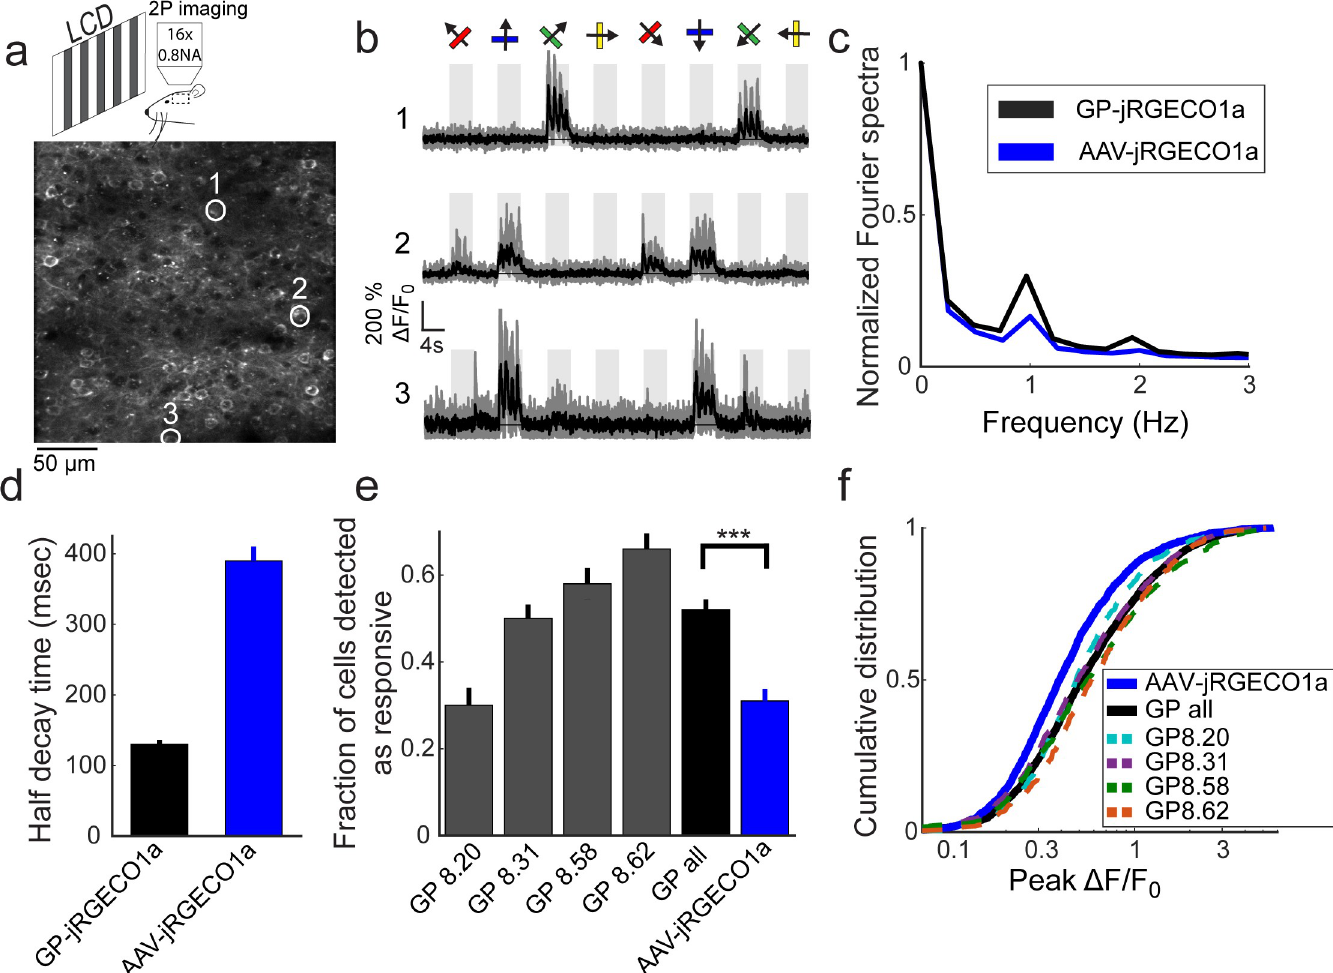
Fig 3. Functional imaging in the primary visual cortex of transgenic mice. a . Schematic of the experimental setup (top), and an image of GP8.31 layer 2/3 cells in the primary visual cortex (bottom, 120 μ m under the dura). b. Responses of three neurons in GP8.31 mice, indicated by circles in a, to drifting grating stimuli. The grating motion directions are indicated by arrows and shown above traces. Single trials (gray) and average of 5 trials (black) are overlaid. The preferred stimulus is the direction evoking the largest response. c. Fourier transform of the response to the preferred stimulus (median across all recorded cells) of GP-jRGECO1a and AAV-jRGECO1a. The 1 Hz peak corresponds to the frequency of the drifting grating (AAV-jRGECO1a, 472 significantly responsive neurons from 4 mice; GP-jRGECO1a, 1650 significantly responsive neurons from 8 mice) d. Half-decay time (mean ± s.e.) after the last response peak during stimulus presentation (GP-jRGECO1a, n = 522 cells from 8 mice; AAV-jRGECO1a, 395 cells from 4 mice). e , Fraction of significant responsive cells (ANOVA test, p < 0.01). Gray bars, single GP lines (n = 2 mice per line. GP8.20, 709 neurons in 14 FOVs; GP8.31, 1416, 19; GP8.58, 607, 12; GP8.62, 628, 19); black bar, averaged data from all GP lines; blue bar, AAV-jRGECO1a data (n = 4 mice, 1747 neurons in 40 FOVs). ��� , p < 0.001 (Wilcoxon Rank Sum Test). f , Distribution of Δ F/F 0 response amplitudes to the preferred stimulus. A right-shifted curve indicates higher response amplitudes. Dashed lines, individual GP lines; black line, compiled data from all GP lines; blue line, AAV-jRGECO1a data (same cells as in e ). AAV-jRGECO1a data is taken from